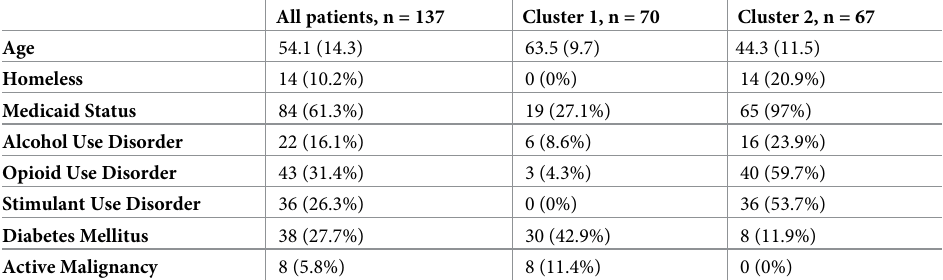
Table 2. Variables included in latent class analysis of patients with spinal epidural abscess, 2015–2019. All patients, n = 137